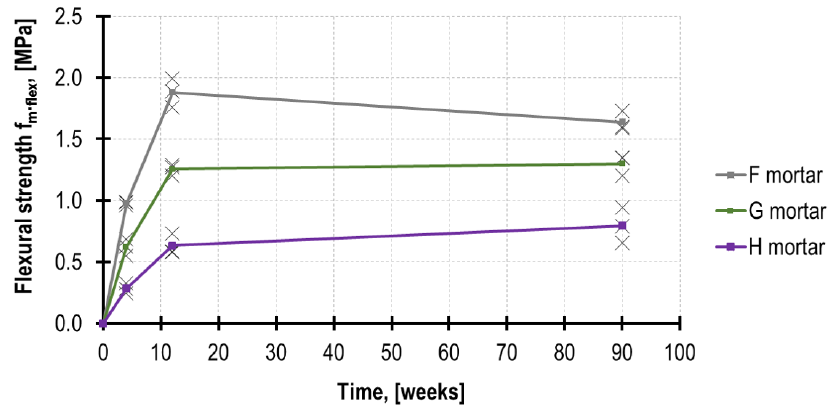
Figure 7. Flexural strength development in time.